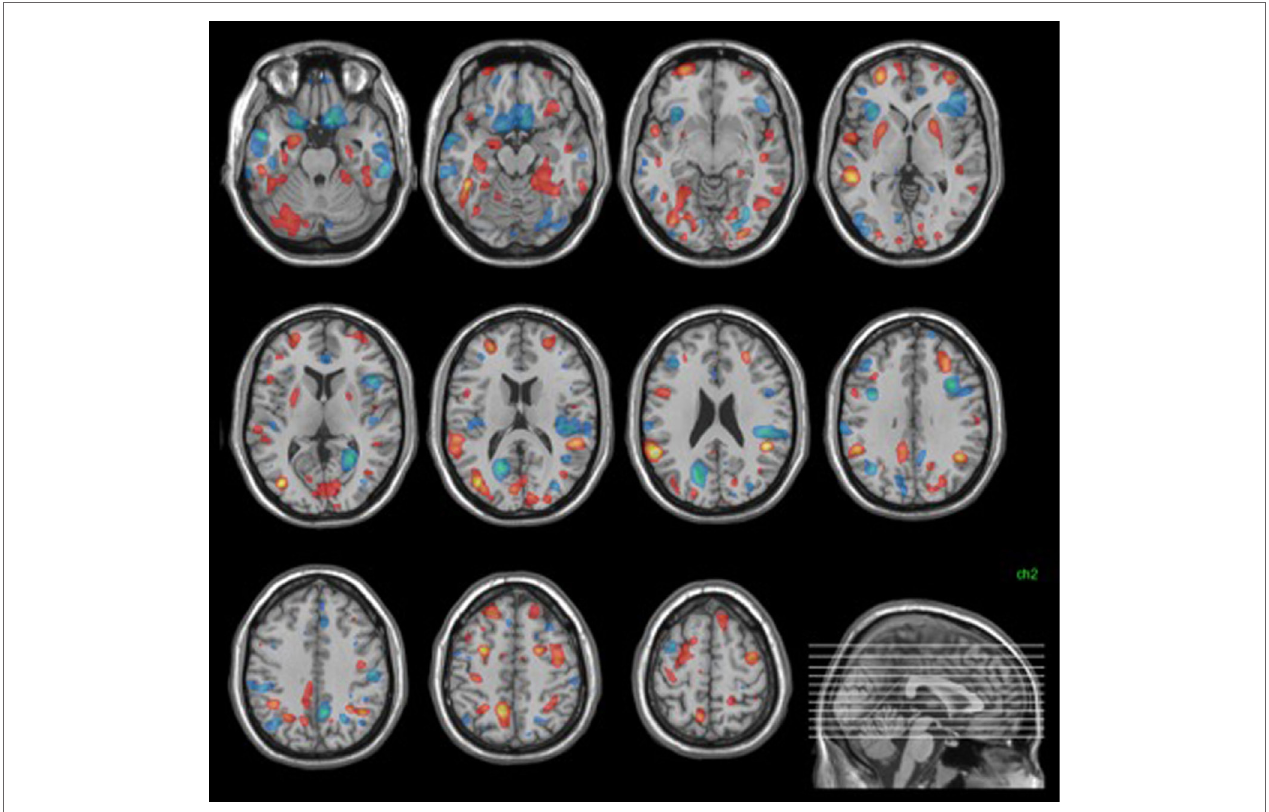
FigUre 2 | structural discrimination map . Areas shown in red were those most distinctive of ARMS group membership. Those in blue were most distinctive of control group membership. Images were thresholded to show the top 30% of voxel weight vector values (positive and